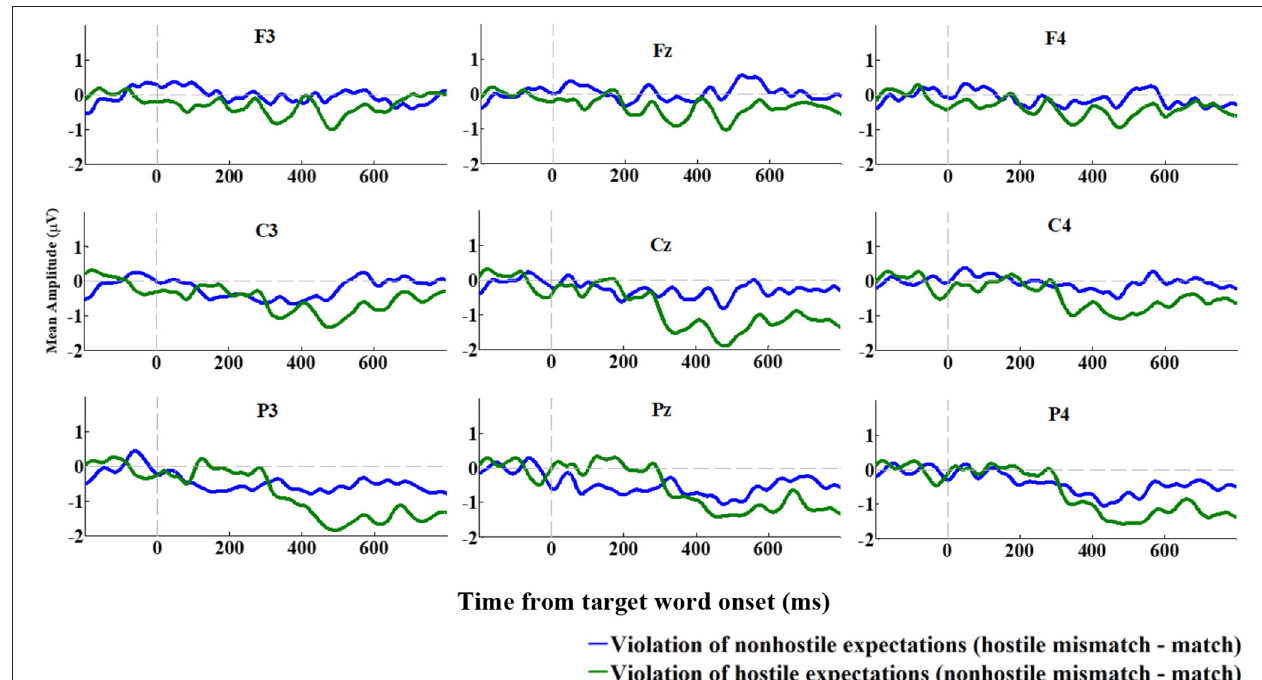
FIGURE 2 | Mean ERP difference waveforms (ERP mismatch minus ERP match) for the hostile and non-hostile condition (blue: hostile; green: